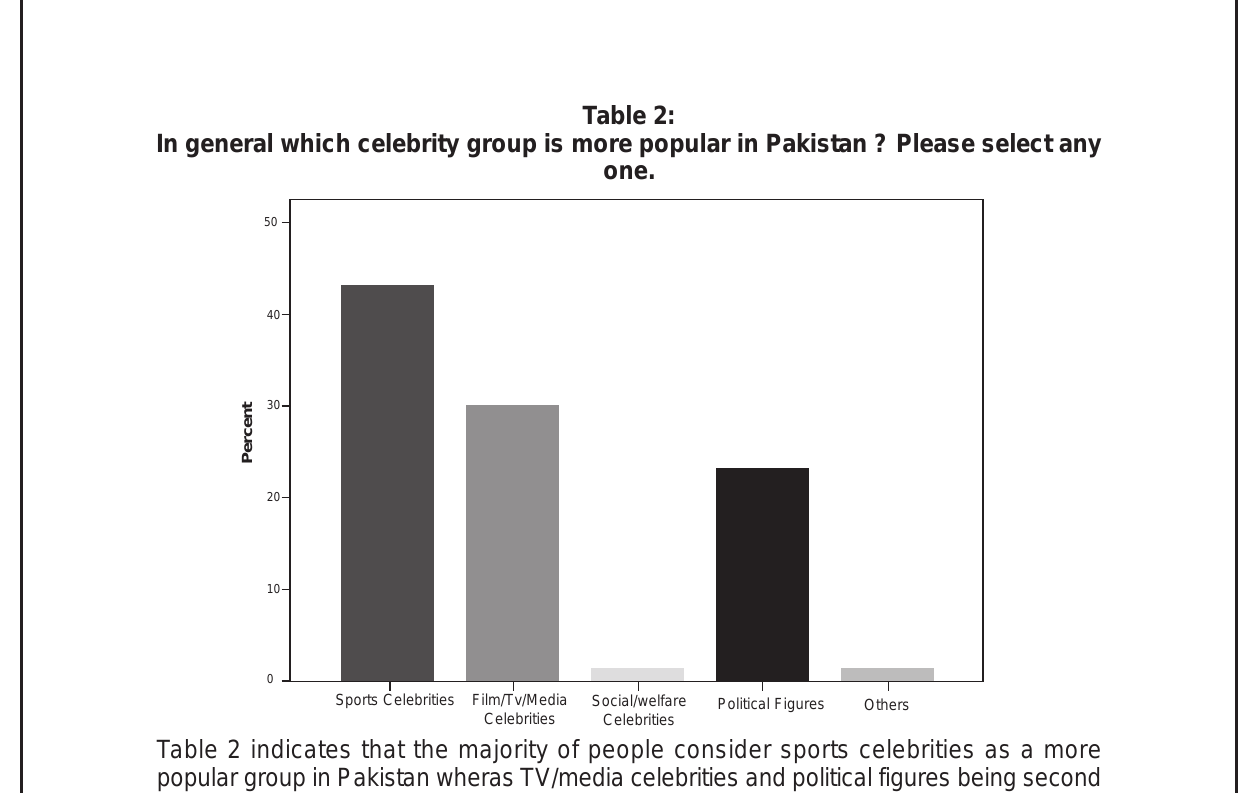
Table 2 indicates that the majority of people consider sports celebrities as a more popular group in Pakistan wheras TV/media celebrities and political figures being second and third